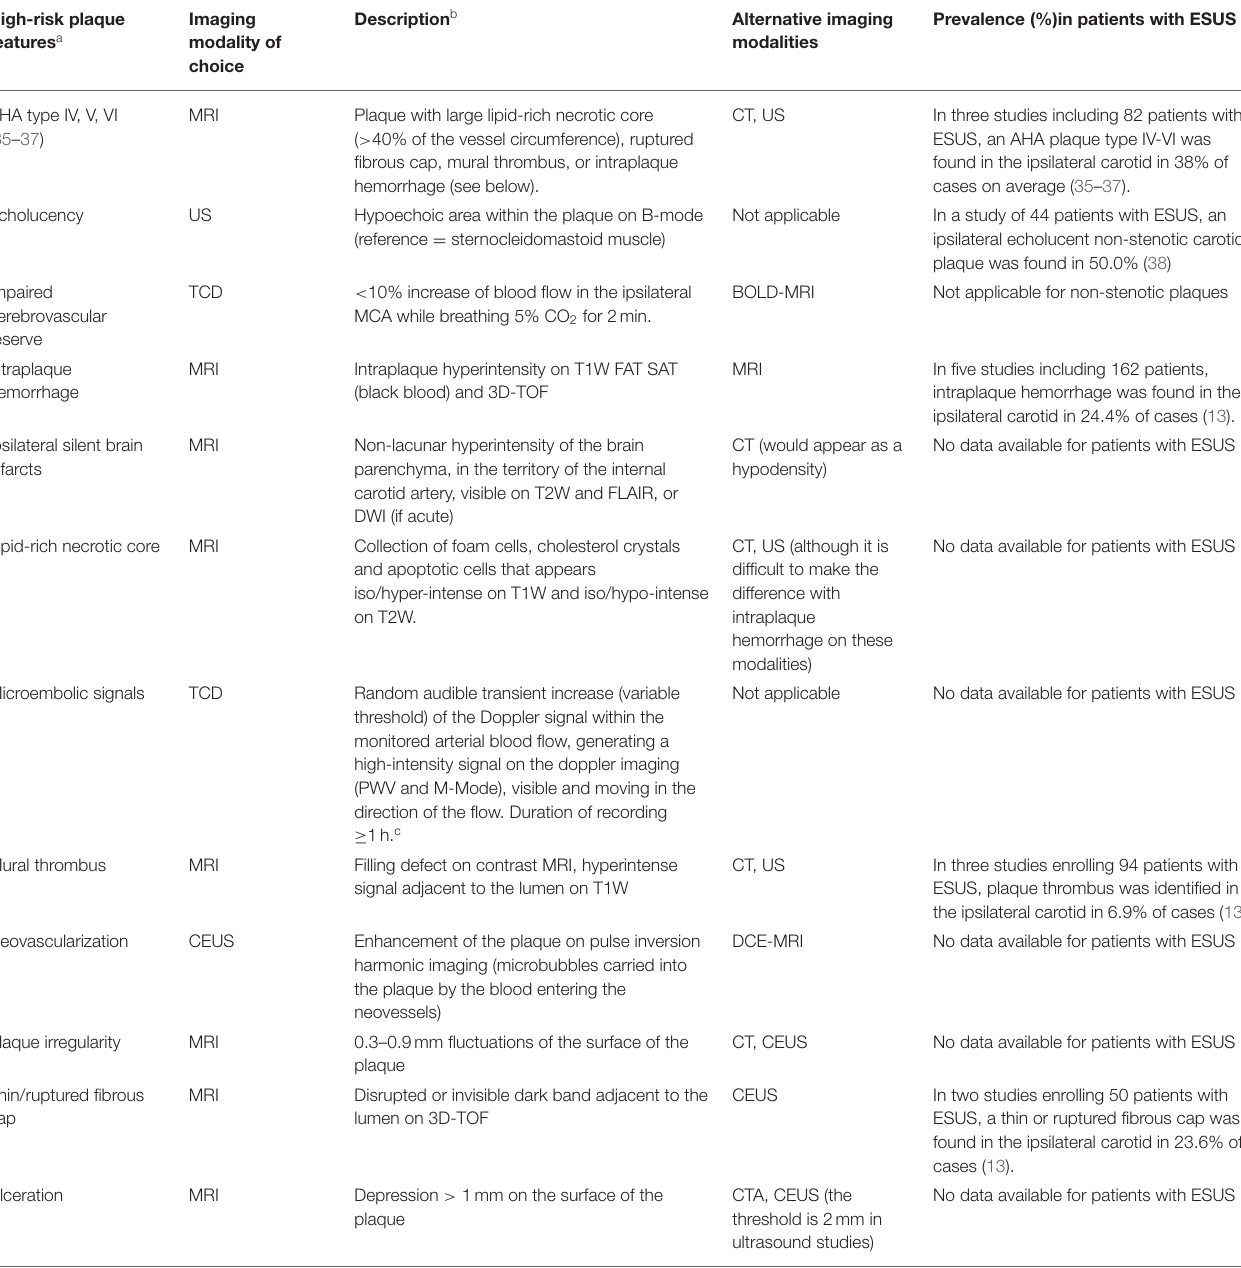
TABLE 2 | High-risk plaque features commonly used in clinical practice (13, 21,